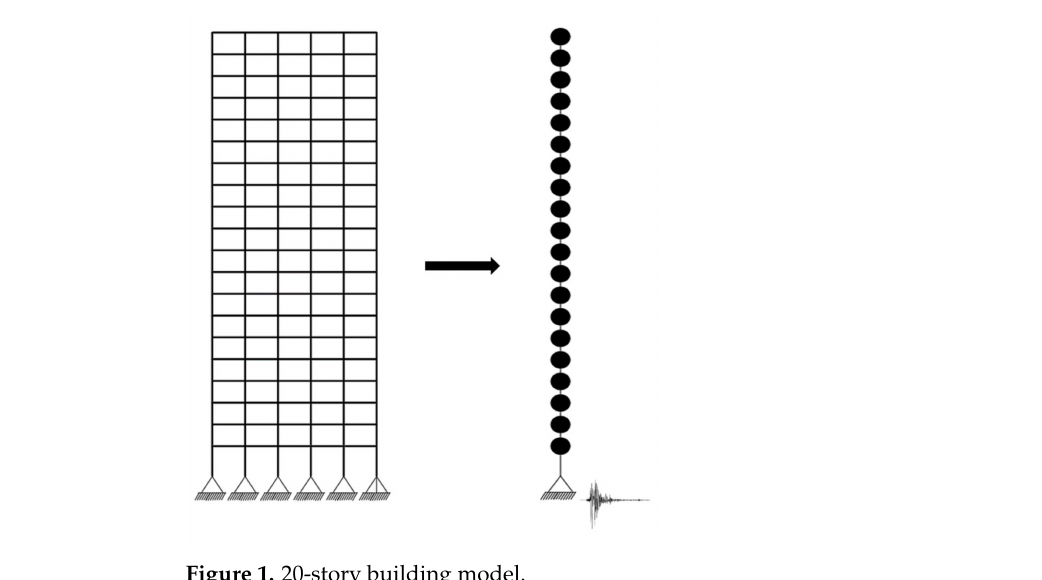
Figure 1. 20-story building model. Table 1. Parameter of 20-story building model.